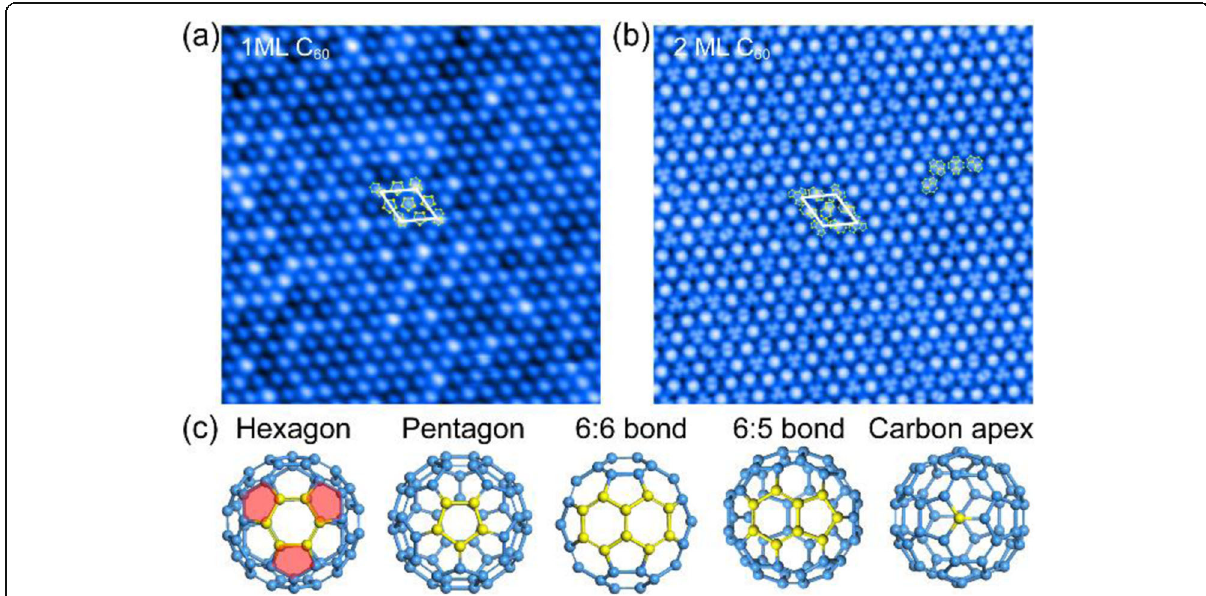
Fig. 3 C 60 orientations in undoped C 60 films. ( a , b ) Empty-state STM images (10 × 10 nm 2 ) of monolayer and bilayer C 60 films. The white rhombuses mark the unit cells of the quasi-(2 × 2) superstructures. ( c ) Sketch maps for five orientations (as labeled) of C 60 molecules viewed from [51]. Taken from Ref.